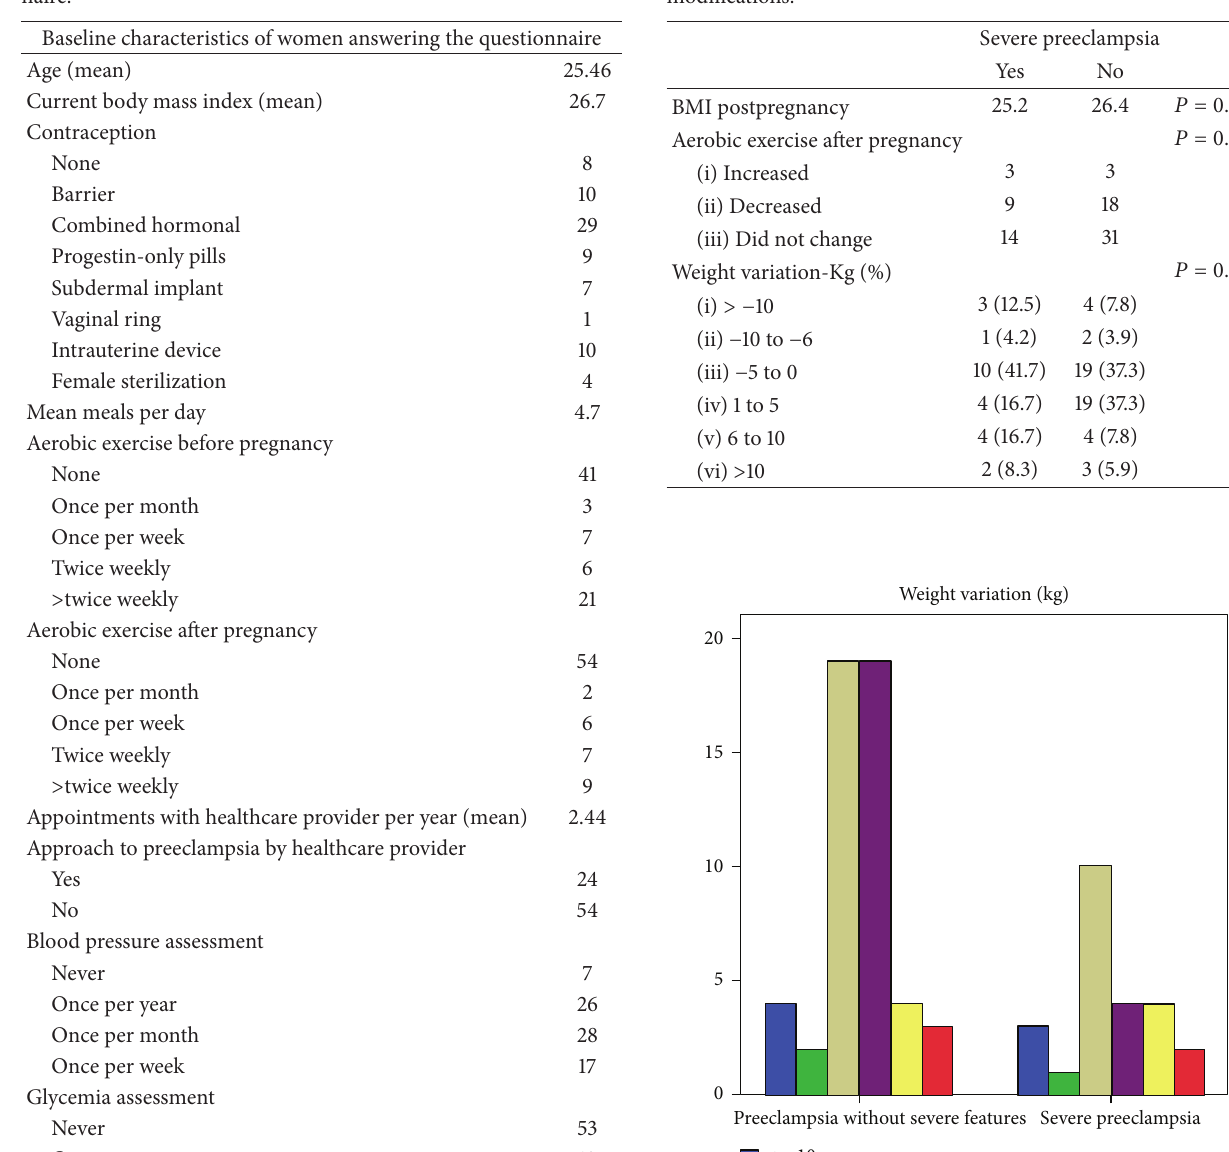
Table 2: Baseline characteristics of women answering the question- naire.